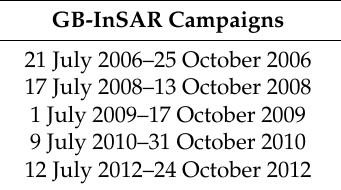
Table 1. Dates of ground-based (GB)-InSAR campaigns.